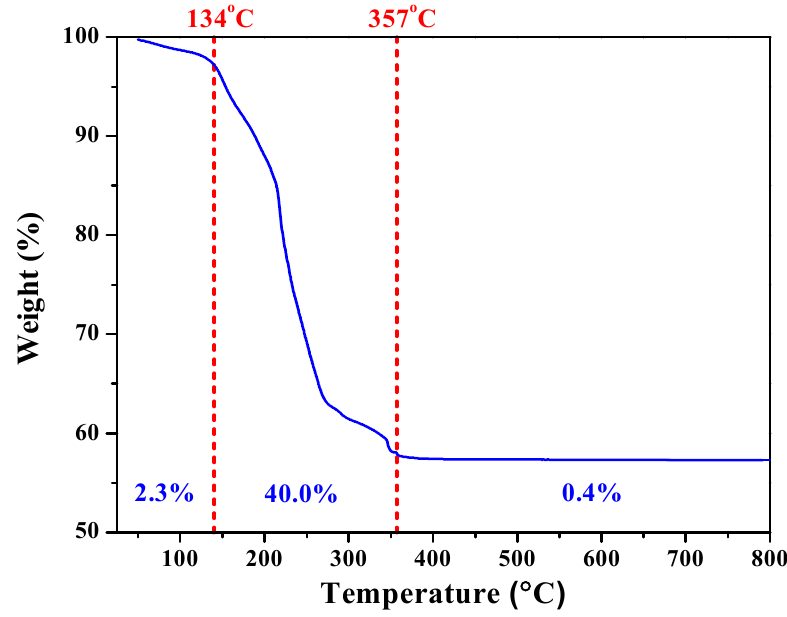
Figure 1. Thermal gravimetric (TGA) curve of sol-gelled SGBH100 powders.